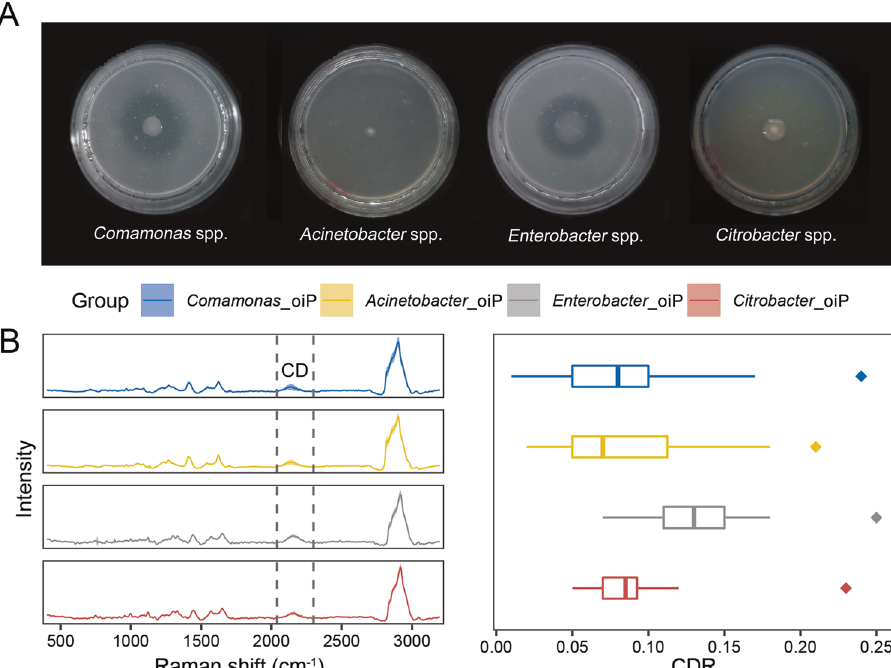
Fig. 5 The phosphorus-solubilizing activity of the scRACS-Culture-derived bacterial strains of Comamonas spp., Acinetobacter spp., Enterobacter spp. and Citrobacter spp. A Halo zones produced on the solid medium of MM-iiP and MM-oiP for those four strains, respectively. B The SCRS and C-D ratios of the four strains, which were incubated in broth media containing 50% D 2 O with Ca 3 (PO 4 ) 2 (iiP) and lecithin (oiP), respectively. Sixty individual cells from each biological replicate sample were